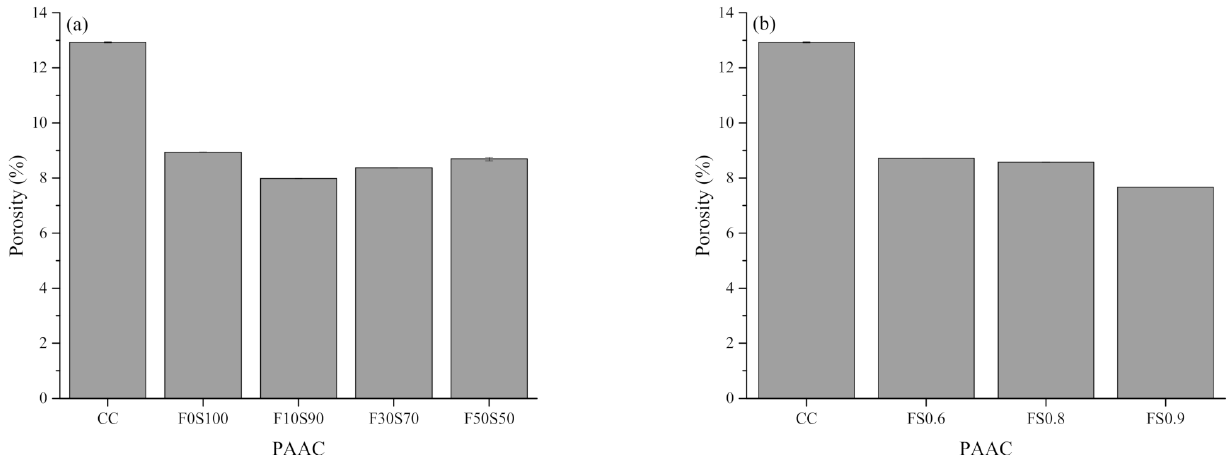
Figure 9. Porosity of preplaced aggregate concrete mixes measured by the total void test: ( a ) Series 1 and ( b ) series